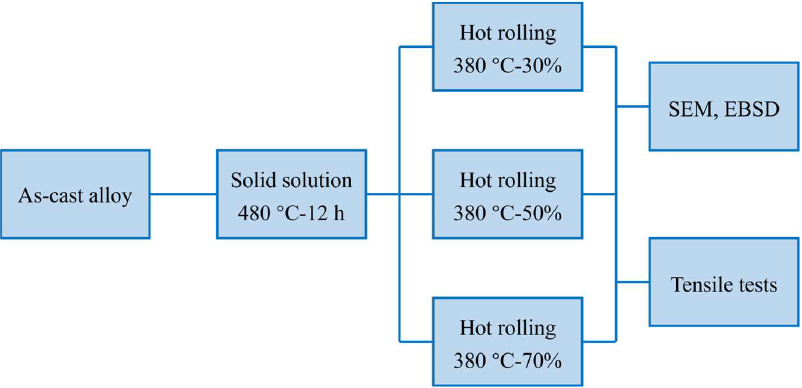
Figure 1. A schematic diagram of the processing route used in this